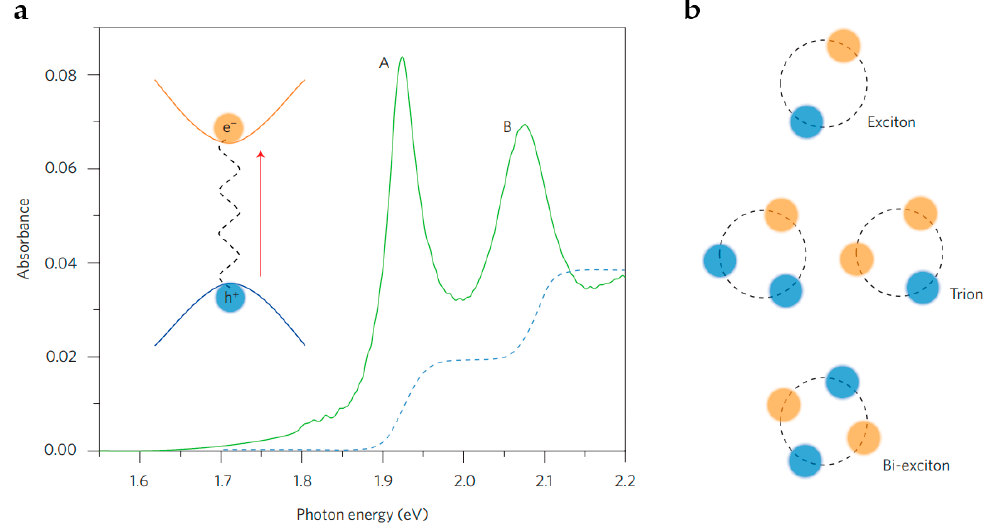
Figure 10. ( a ) Absorption spectrum of monolayer MoS 2 at 10 K (solid green line). Exciton resonances A and B correspond to the transition of electron–hole pairs from two valence bands split by spin to the conduction band. The absorbance in the absence of excitonic effects is represented by the blue dotted line (in arbitrary units). The inset depicts the Coulomb attraction between the electron–hole pairs generated optically, resulting in the formation of a bound exciton. ( b ) Illustration of excitons and higher-order exciton complexes, including a two-particle neutrally charged exciton, a three-particle charged exciton (trion), and a four-particle double exciton. (Reprinted with permission from ref. [128]. Copyright 2016 Springer Nature Publications).